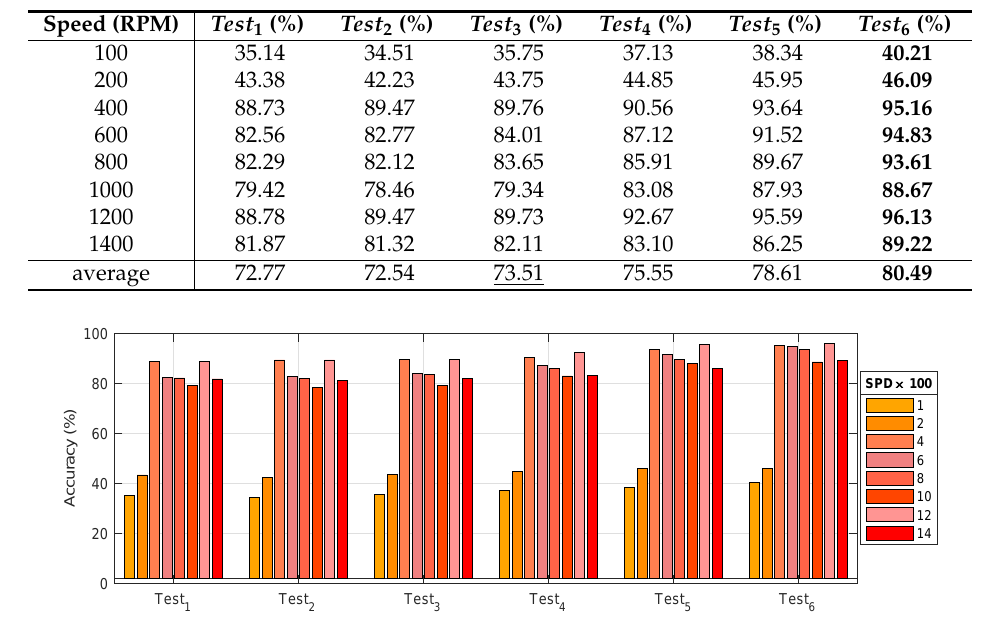
Table 5. Group test results using HDBN.